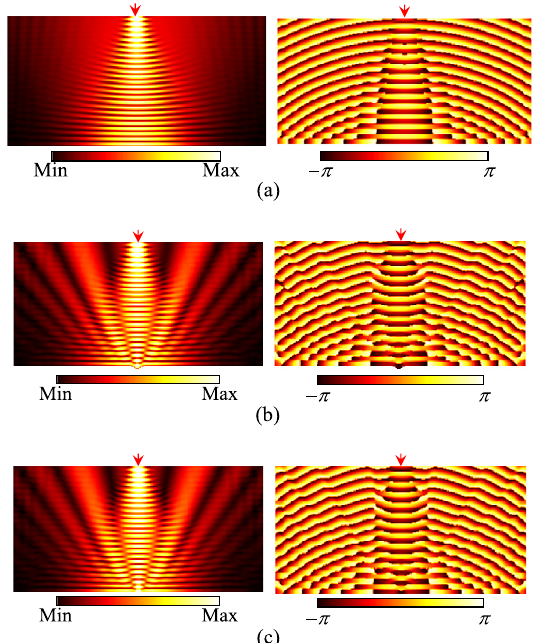
Fig. 9. Calculated complex voltage distributions for the case with the normal incident wave at the wavelength l g = 12 D d . Left: Amplitude. Right: Phase. (a) Flat surface. (b) With the original groove. (c) With the groove illusion